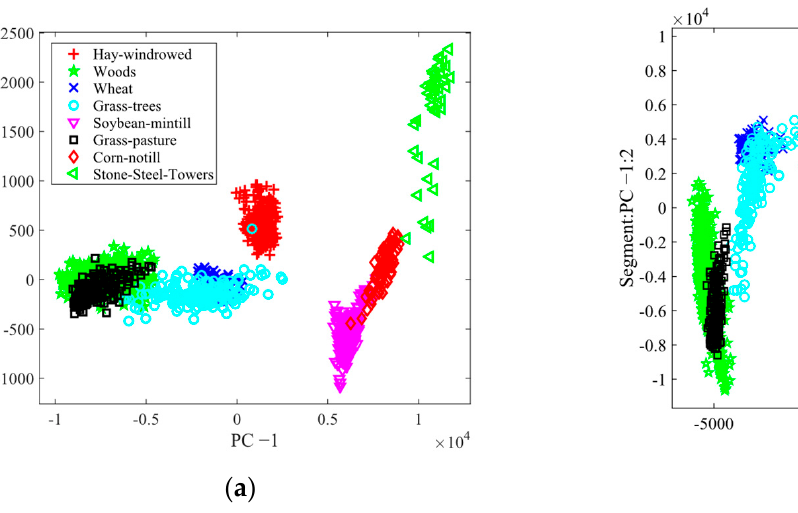
Table 5. Detailed classification outcomes for the Indian Pines dataset.